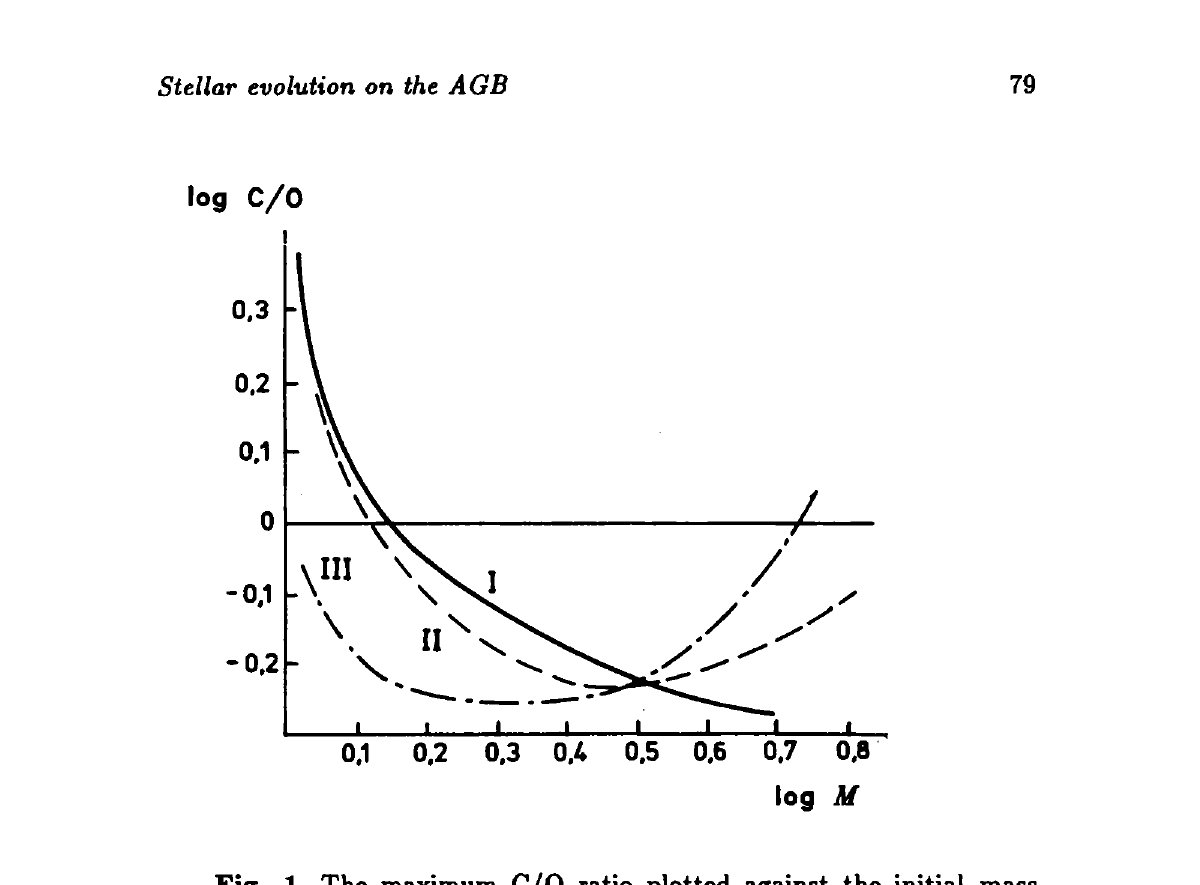
Fig. 1. The maximum C/0 ratio plotted against the initial mass (M) for different values of the Reimers mass-loss coefficient a: (I) a = c*o + ai expilic, where M is the mass of a carbon-oxygen core and the c coefficients αο, αϊ are chosen so that α =0.33 if M =0.5 MQ and a=10 c if M (II) A=L if log(L/L©) < 4.1 and a = 10 (a tenfold jump C = 1 .0 M©; of mass loss intensity) if log(L/L©) > 4.1; (III) α =